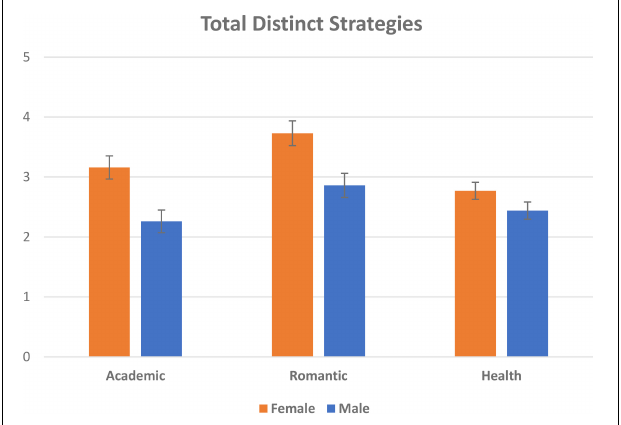
FIGURE 2 | Means and standard deviations for gender differences in total distinct strategies within each scenario. Error bars represent the standard error of the means.